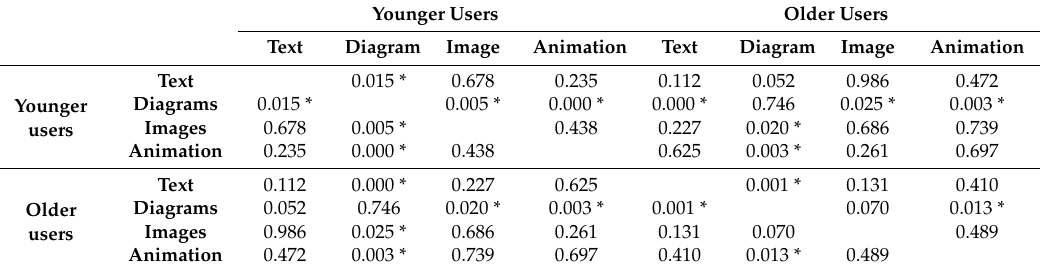
Table 22. Post-hoc screen test of younger and older